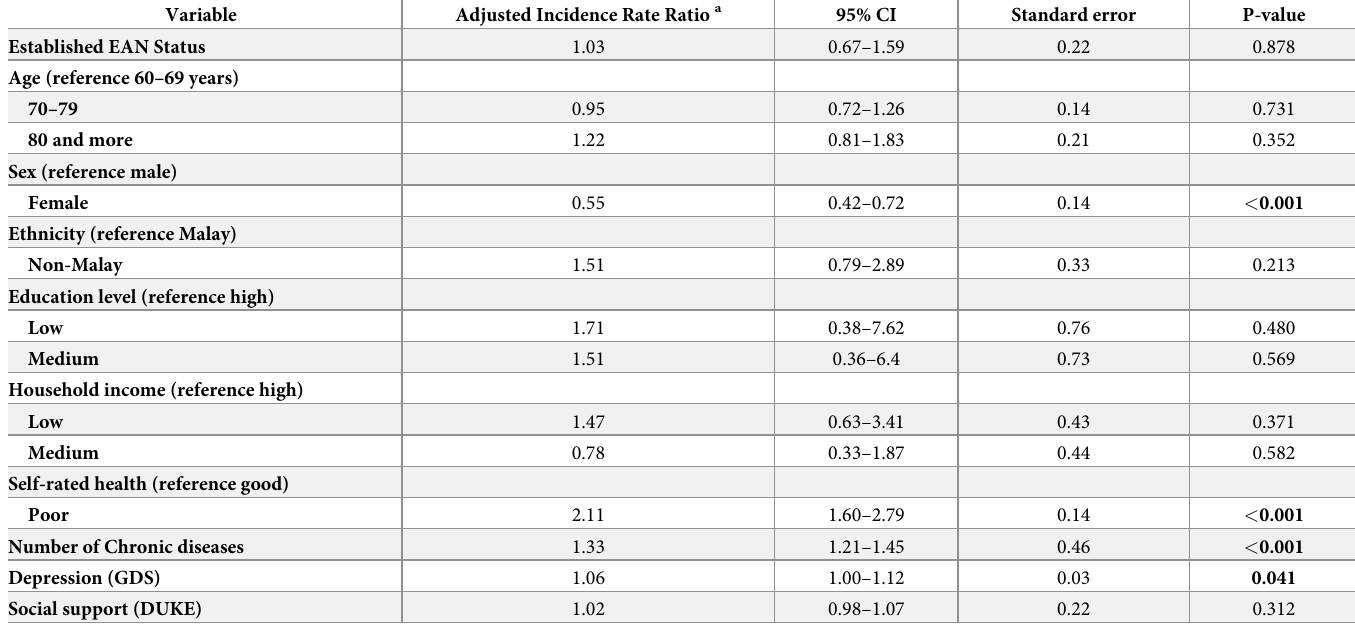
Table 4. Multivariable regression table to show the association between EAN status and hospitalization.